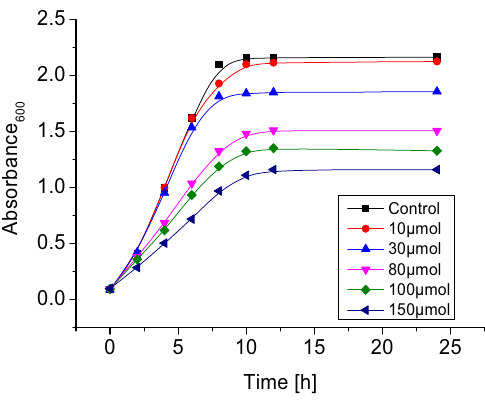
Figure 4: Growth curves of E. coli during the course of a 24 h culti - vation in the presence of 10; 30; 80; 100; and 150 μ mol of the complex 2 .